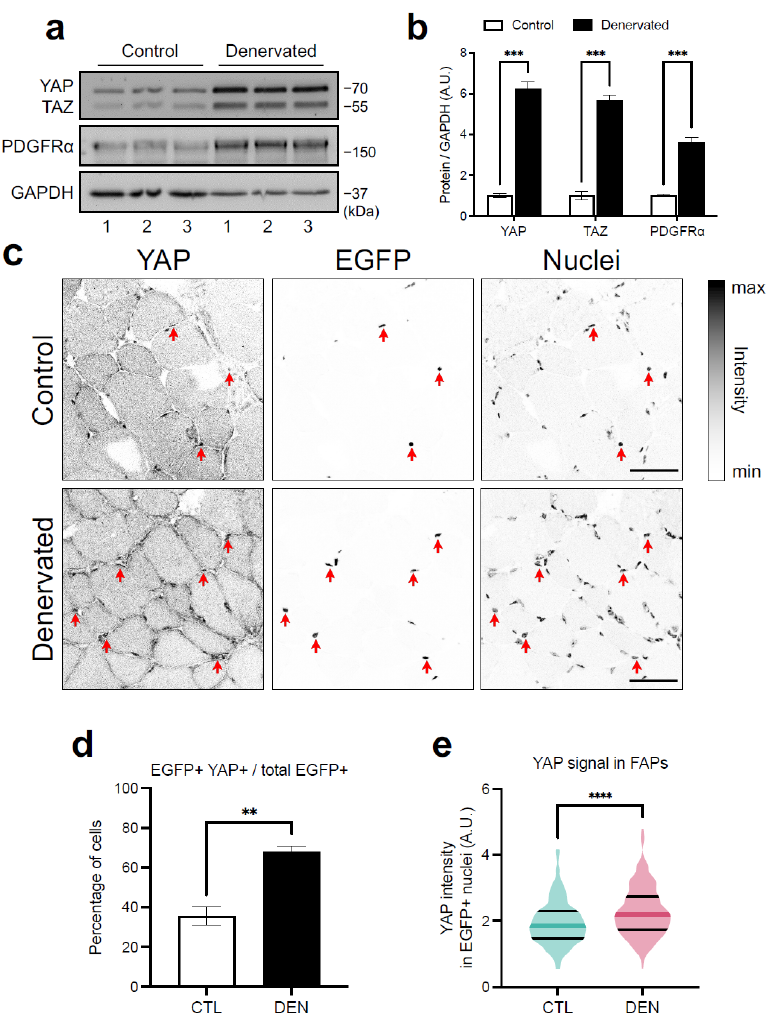
Figure 4. Denervation induces YAP accumulation in FAPs. ( a ) Western blot showing YAP/TAZ and PDGFR α protein expressions in denervated and control TA muscles from the Pdgfra H2B:EGFP/+ mice. PDGFR α and GAPDH expressions were used as a FAPs marker and loading control, respectively. The numbers at the bottom indicate each independent mouse. ( b ) Densitometric analysis of YAP/TAZ and PDGFR α signals normalized to GAPDH. A.U. = arbitrary units. N = 3 independent mice. *** = p < 0.001; unpaired t test. ( c ) Representative section of TA showing YAP, EGFP, and total nuclei signals in muscles as in ( a ). Red arrows indicate YAP and EGFP overlay. Scale bar = 50 μ m. ( d ) Quantification of the percentage of FAPs (EGFP positive nuclei) expressing YAP (YAP positive and EGFP positive nuclei). ( e ) Quantification of YAP signal intensity in FAPs. A.U. = arbitrary units. N = 3 independent mice. ** = p < 0.01, **** = p < 0.0001; unpaired t test.